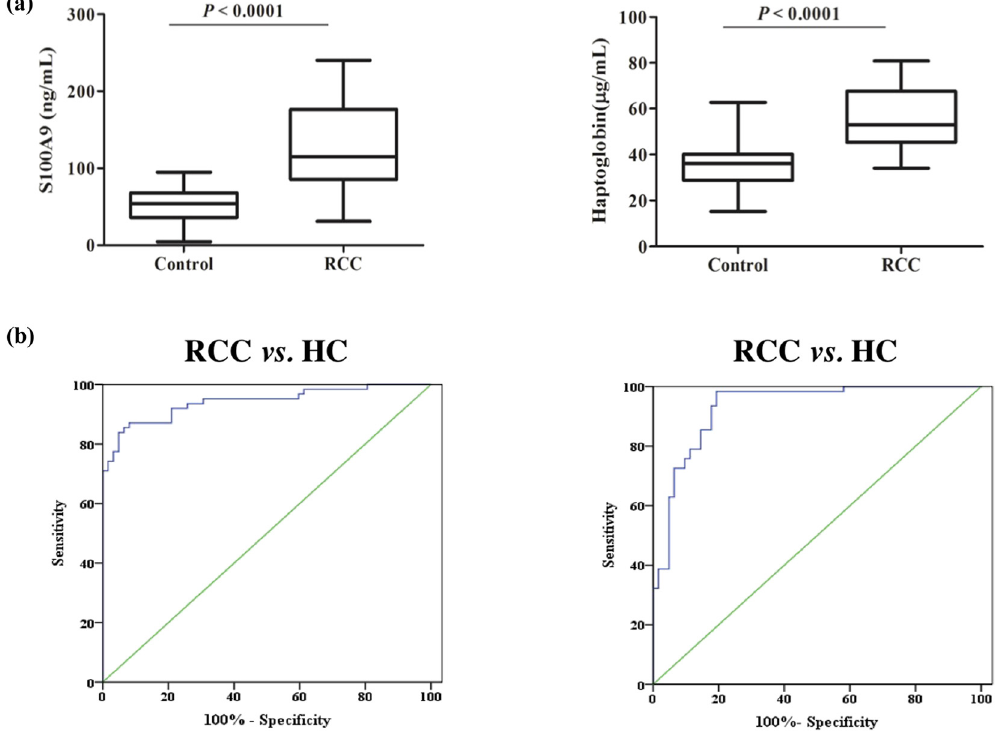
Figure 3: E ffi cacy of S100A9 and haptoglobin in discriminating RCC. ( a ) Box plots denoting 25 to 75th percentiles for the expression of S100A9 and haptoglobin in the saliva of RCC patients and healthy controls by ELISA. ( b ) The ROC curve analysis for salivary S1A9 and haptoglobin in the diagnosis of